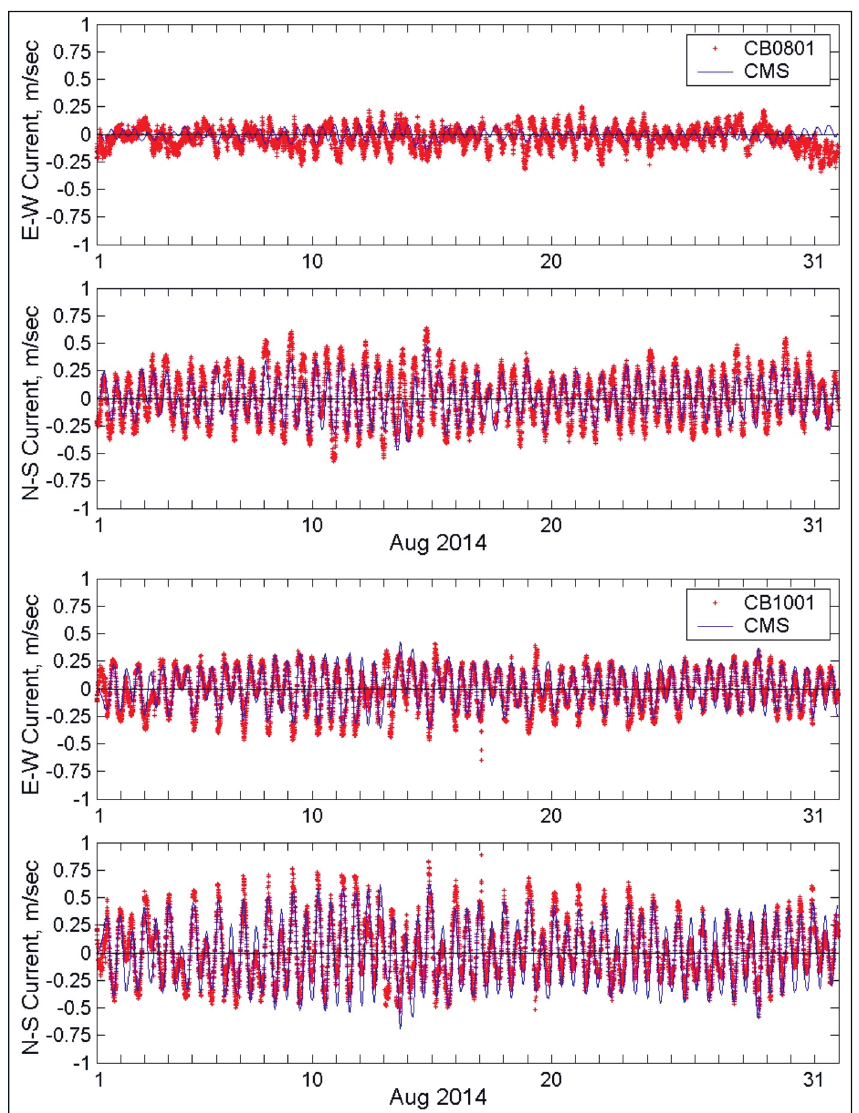
Figure 9. Comparison of calculated depth-averaged current components and measured surface current data at NOAA Stations CB0801 and CB1001 for August